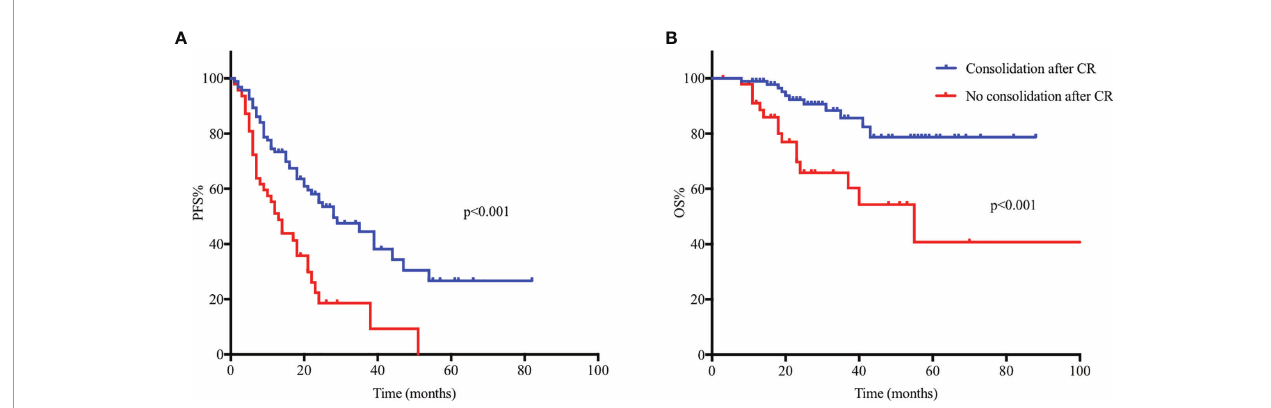
FIGURE 3 | Kaplan-Meier analysis of progression-free survival (PFS) and overall survival (OS) in 143 PCNSL patients and comparison of PFS and OS between groups proceeded to consolidation (n=95) and who did not (n=48). (A) The median PFS was 28 months (95% CI 17.11-38.89) and 12 months (95% CI 7.74-16.26) (p < 0.001) for patients who completed sequential consolidation chemotherapy (n=95) and those who did not (n=48). (B) The median OS for patients who completed sequential consolidation chemotherapy (n=95) was not reached, for those who did not completed consolidation (n=48), the median OS was 55 months (95% CI 29.8-80.2).